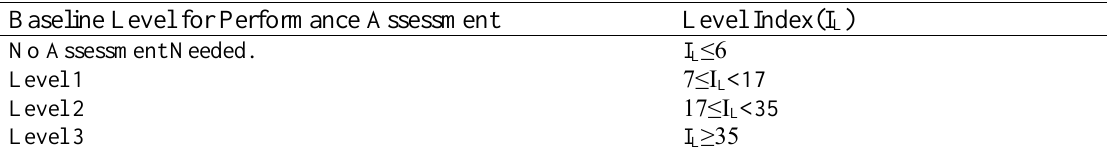
Table 8. Selection of Appropriate Levels of Analysis Baseline Level for Performance